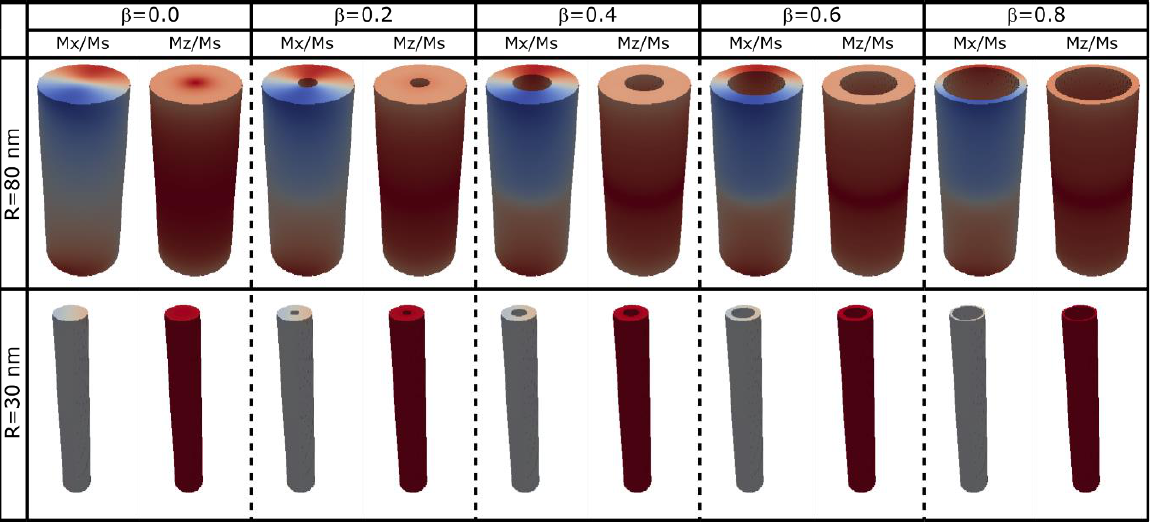
Figure A4. Components of the magnetization (Mx/Ms and Mz/Ms) for each of the geometries that were excited to investigate the FMR spectrum of the 1000 nm long Fe 3 O 4 nanotubes.